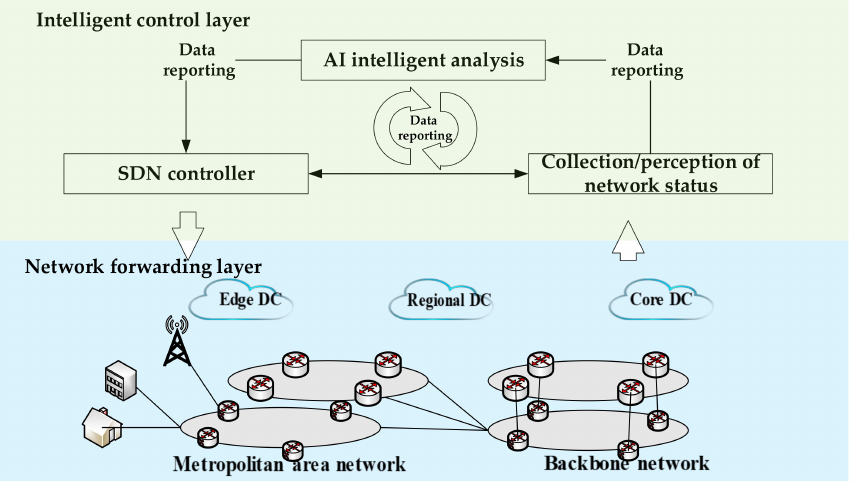
Figure 1. Architecture of intelligent network